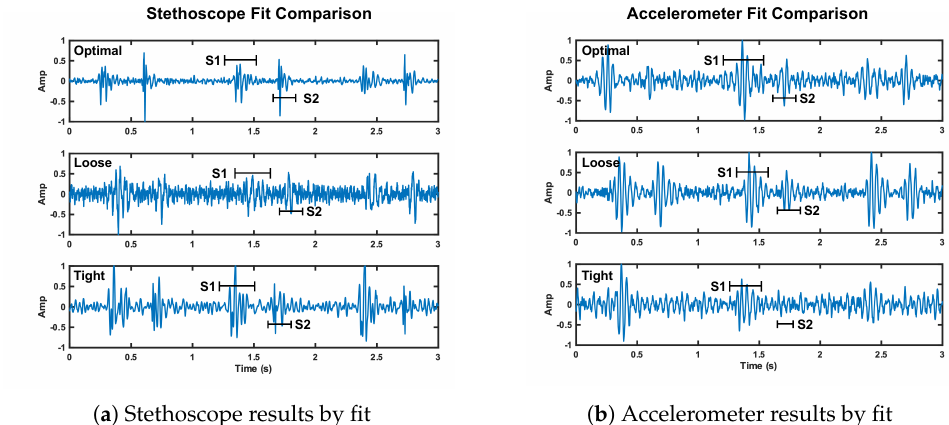
Figure 14. Depiction of the change in signal quality for the stethoscope (plot a ) and accelerometer (plot b ) over three cardiac cycles when the fit of the chest band is altered. The noise floor is visibly higher compared to reference fit for the stethoscope loose and tight fit, and the accelerometer tight fit.